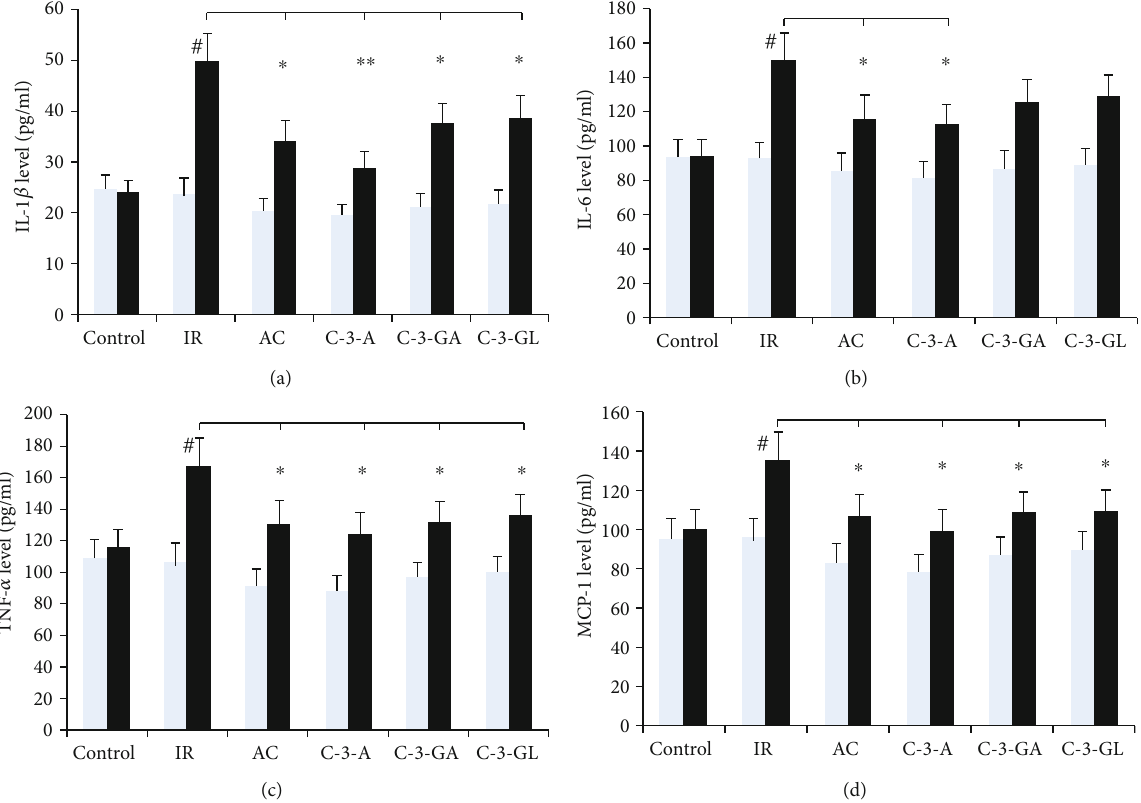
Figure 3: Proin fl ammatory cytokine ’ s levels in blood in the renal IR injury and anthocyanin treatment. The data are the means ± SD . n = 13 per group. (a) IL-1 β : interleukin-1 beta. (b) IL-6: interleukin-6. (c) TNF- α : tumor necrosis factor- α . (d) MCP-1: monocyte chemoattractant protein. IR: ischemia/reperfusion; AC: anthocyanins; C-3-A: cyanidin-3-arabinoside; C-3-GA: cyanidin-3-galactoside; C-3-GL: cyanidin-3- glucodise. The comparison between treated mice and IR was indicated by asterisks. # P < 0 : 01 vs. control within group; ∗ P < 0 : 05 and ∗∗ P < 0 : 01 vs. respective IR